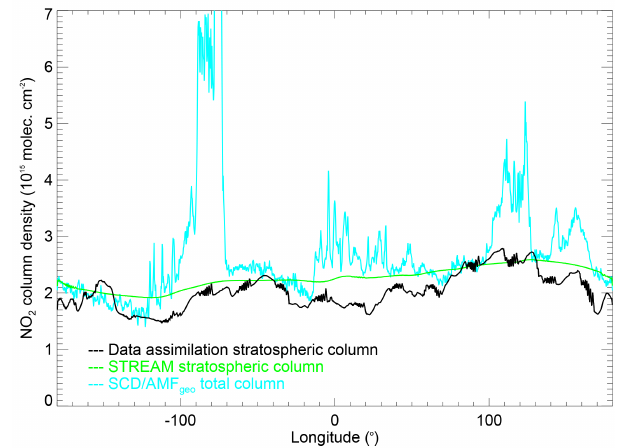
Figure 7. Meridional average QA4ECV OMI NO 2 column av- eraged over 39–41 ◦ N on 2 February 2005. No cloud radiance, albedo, or AMF filtering have been applied. Data assimilation and STREAM stratospheric columns are indicated in the black and green lines; the total slant columns divided by the geometric AMF are light blue. Both data assimilation and STREAM stratospheric column estimates are included in the QA4ECV NO 2